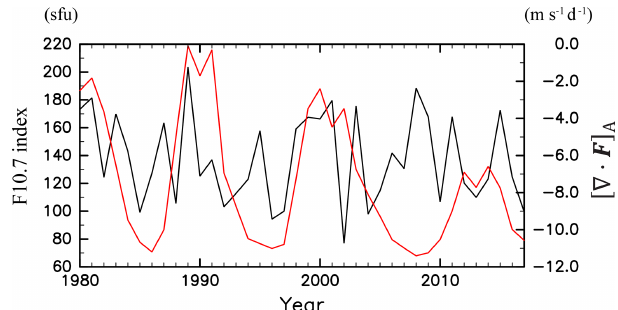
Figure 7. Time series of the JJA mean F10.7 index (red, sfu = 10 − 22 Wm − 2 Hz − 1 ) and [∇ · F ] A (black, ms − 1 d − 1 ) for 1980–2017.